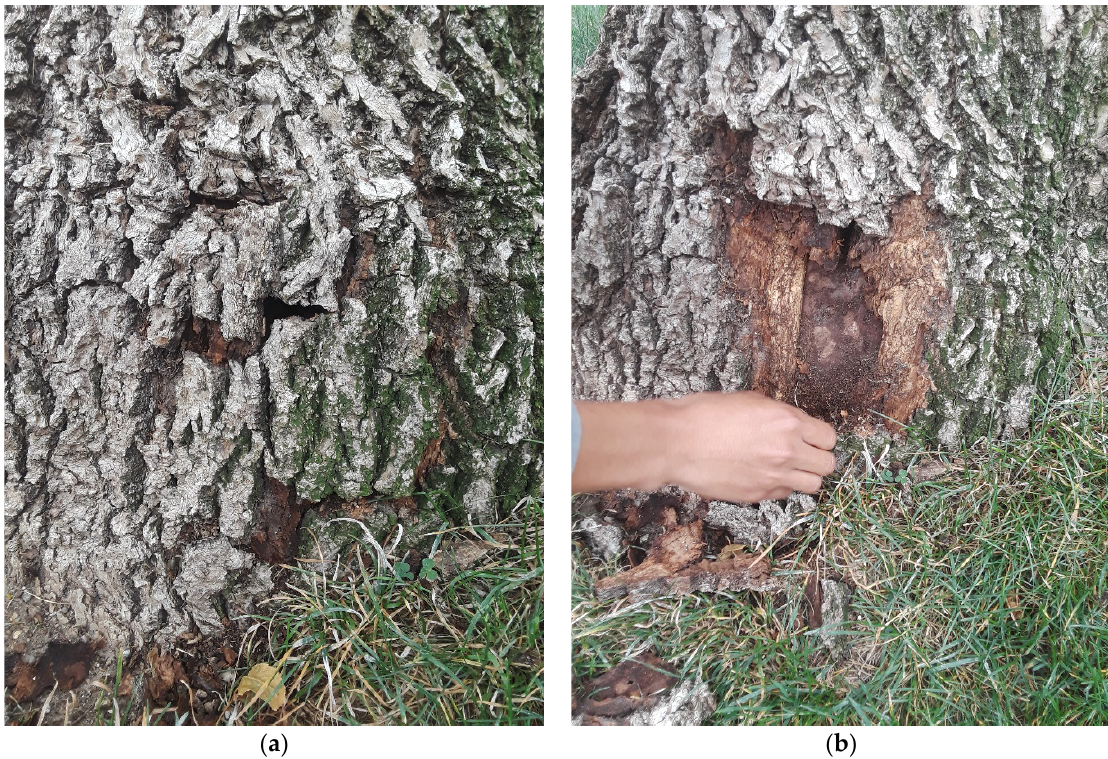
Figure A2. Plug appearance of improper application ( a ) set shallow and associated ( b ) bark cracking.